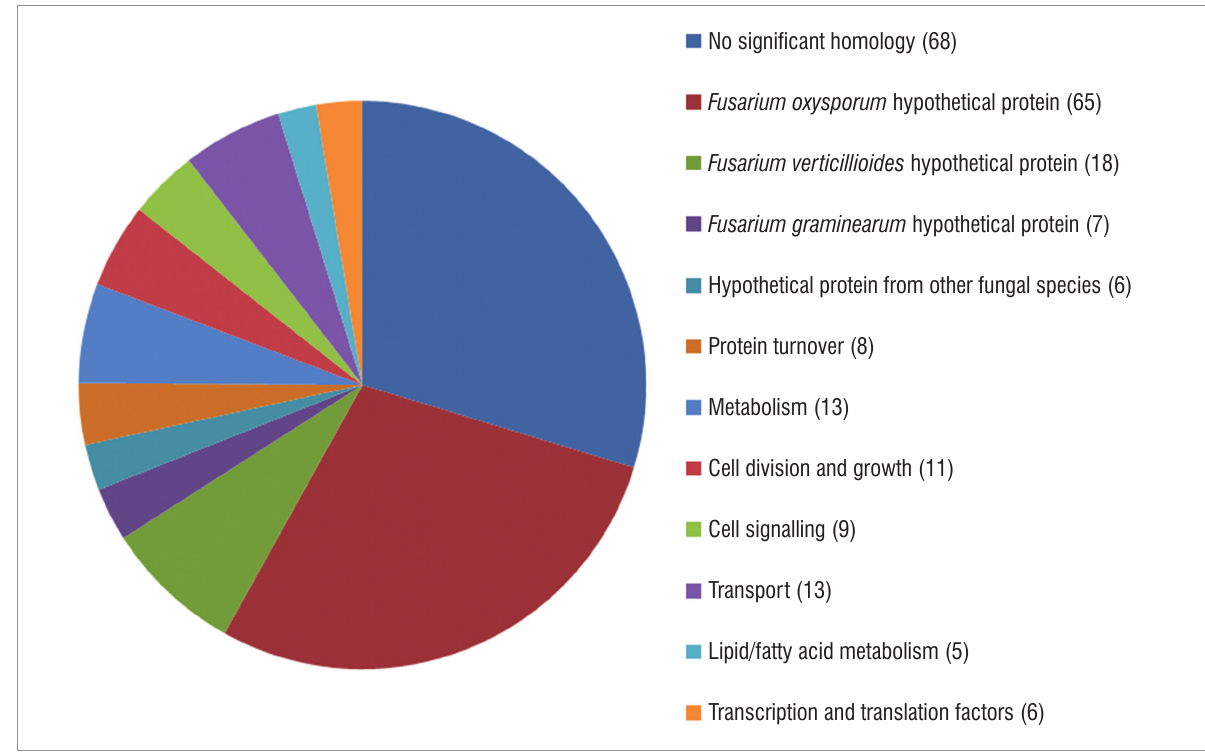
Figure 1: Classification of differentially accumulated transcript derived fragments (TDFs) after growth of Fusarium oxysporum f. sp. cubense and non- pathogenic F. oxysporum in minimal medium without a carbon source. A total of 229 TDFs were classified based on the BLASTX homology search on the Broad Institute database. Values in parentheses indicate the number of TDFs found in each